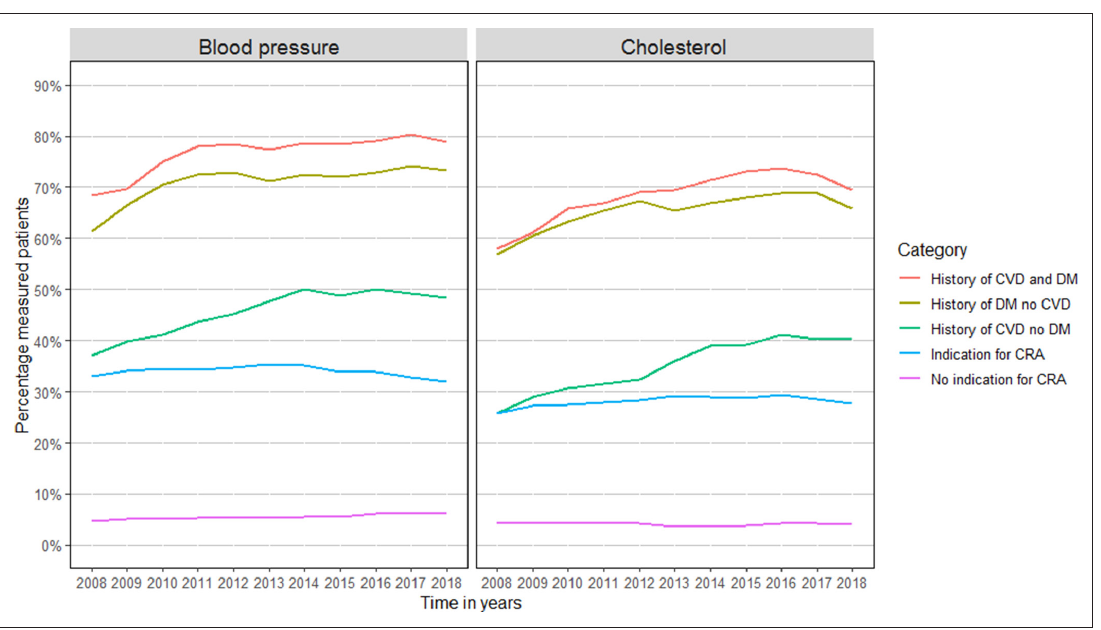
Figure 1 Trends in annual BP and cholesterol measurement stratified for medical history. Patients were classified as ‘Indication for CRA’ if they did